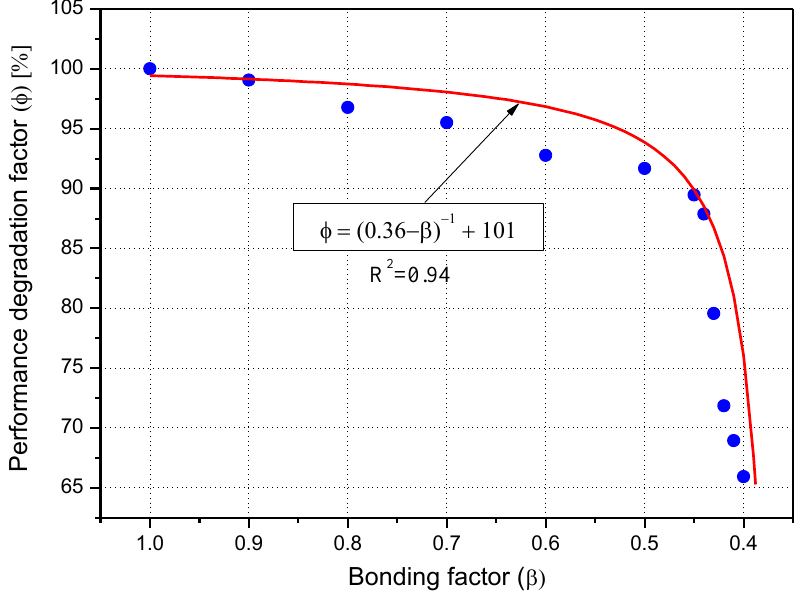
Figure 14. Relationship between bonding factor ( β ) and performance reduction factor ( ϕ ) of flexural beam specimens (FEM analysis).